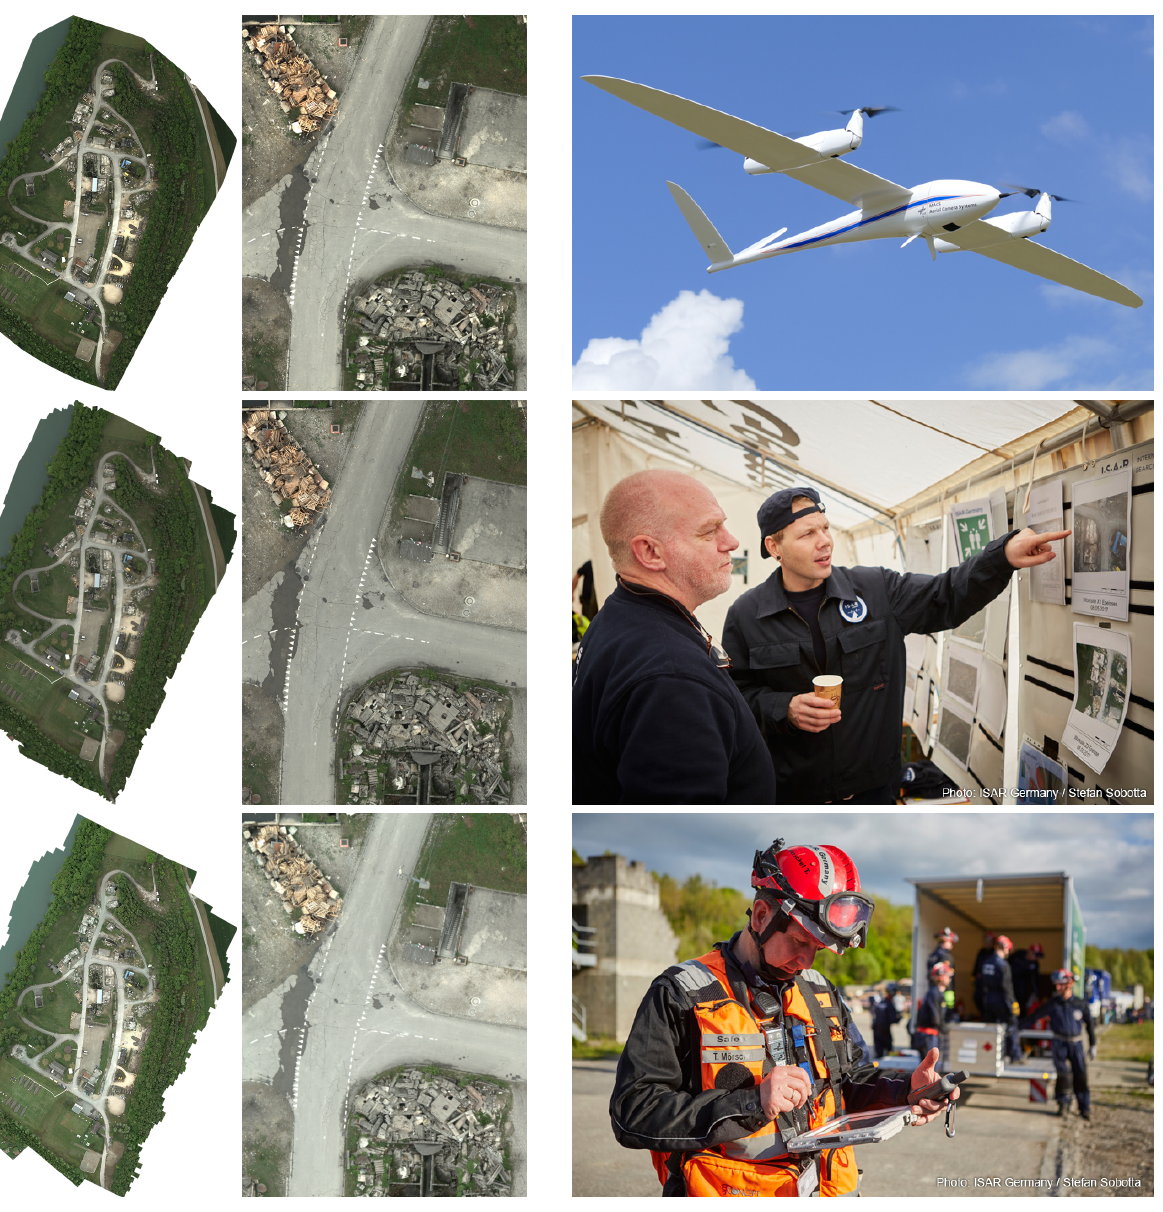
Figure 4. Quick orthophoto mosaic comparison: Results for a sample scene of 0 , 28 km 2 , comprising 254 aerial images with an average GSD of 2 . 7 cm . Left: full scene, Right: detail view. Top: Pix4DMapper, Center: Agisoft PhotoScan Professional, Bottom: Quick mosaic generated with TAC algorithm. Pro- cessing times shown in figure 5.